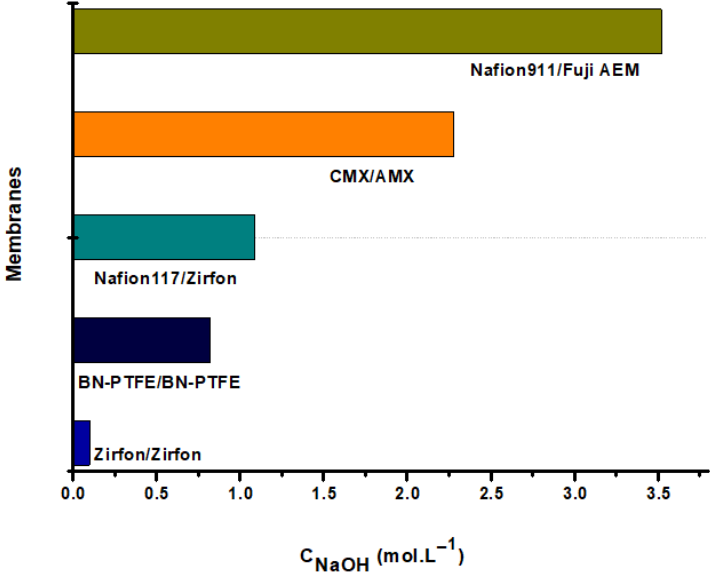
Figure 10 . Quantity of NaOH generated in the cathodic compartment with I = 500 mA. Figure 10. Quantity of NaOH generated in the cathodic compartment with I = 500